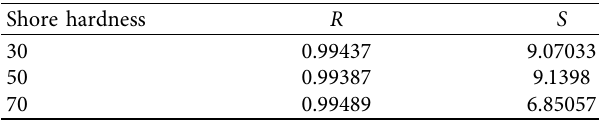
Table 3: Correlation coefficient and standard deviation of the three kinds of finger bending angle